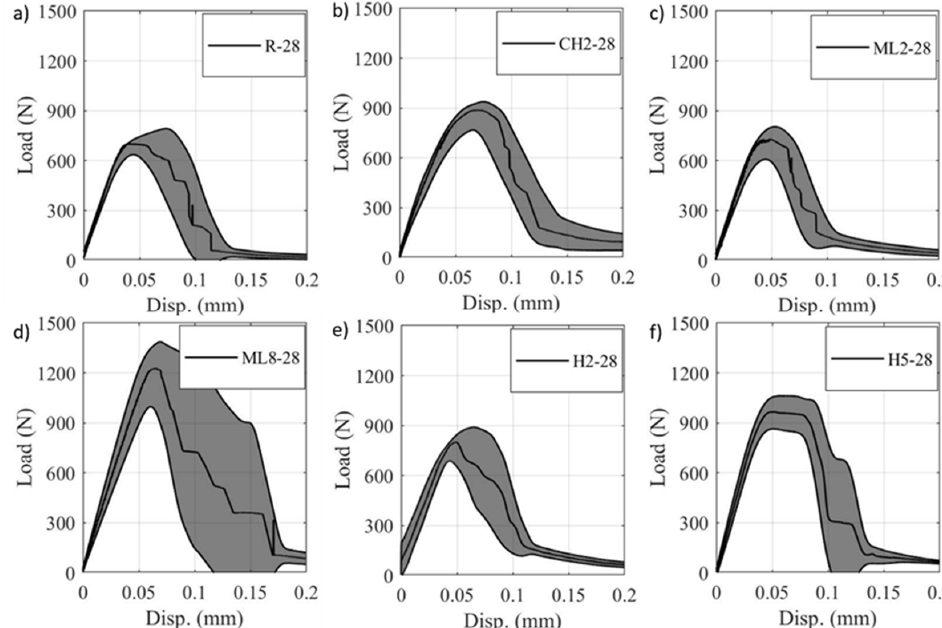
Figure 9. Comparison of unnotched beam bending mean and variance response for the ( a ) reference and carbon fiber reinforced cementitious composite mixes (( b ) CH2, ( c ) ML2, ( d ) ML8, ( e ) H2, and ( f ) H5) at 28 days of age. Each graph represents the mean of five tested samples.